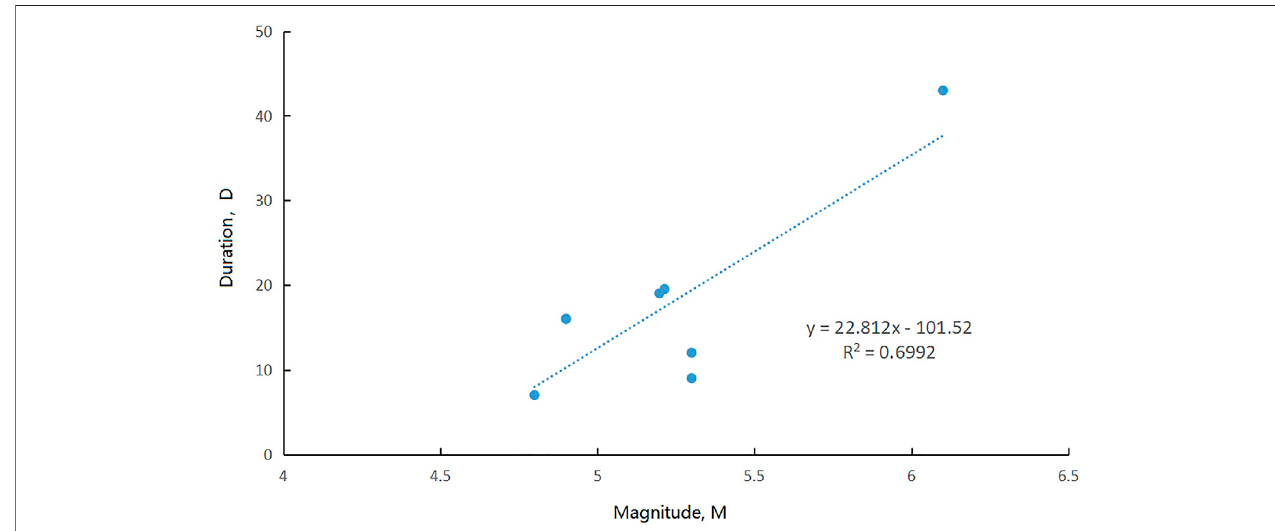
FIGURE 5 | Linear regression of cloud anomaly duration and Magnitude.